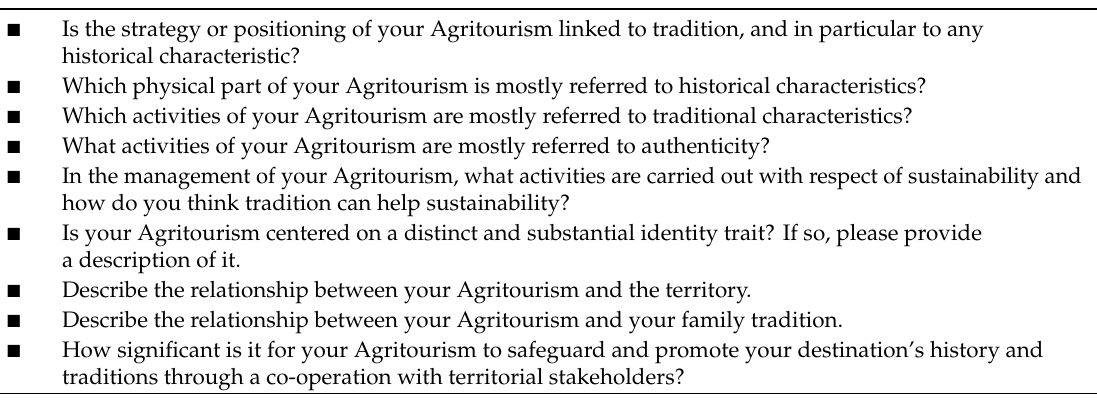
Table A1. Questionnaire filled in by the owners / managers of the agritourism